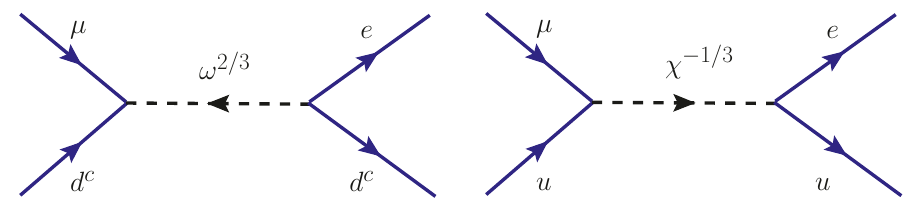
Figure 24 . Feynman diagrams leading to (cid:22)